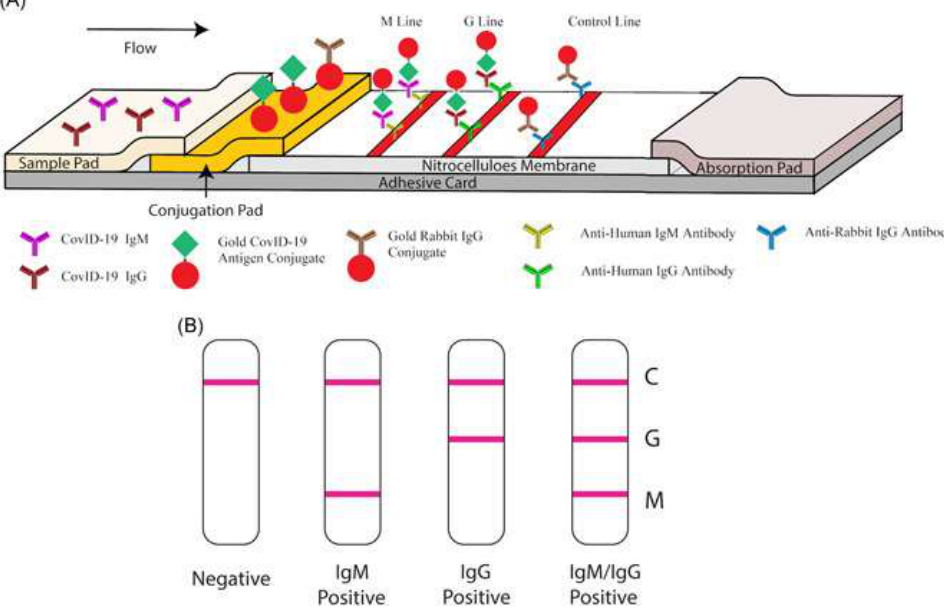
Figure 6. Illustration of rapid SARS-CoV-2 IgM-IgM combined antibody test. ( A ) Schematic of detection device; ( B ) Illustrations of different possible results (C: Control line; G: IgG line; M: IgM line). Reproduced from [94] under the Creative Commons Attribution 4.0 International License.